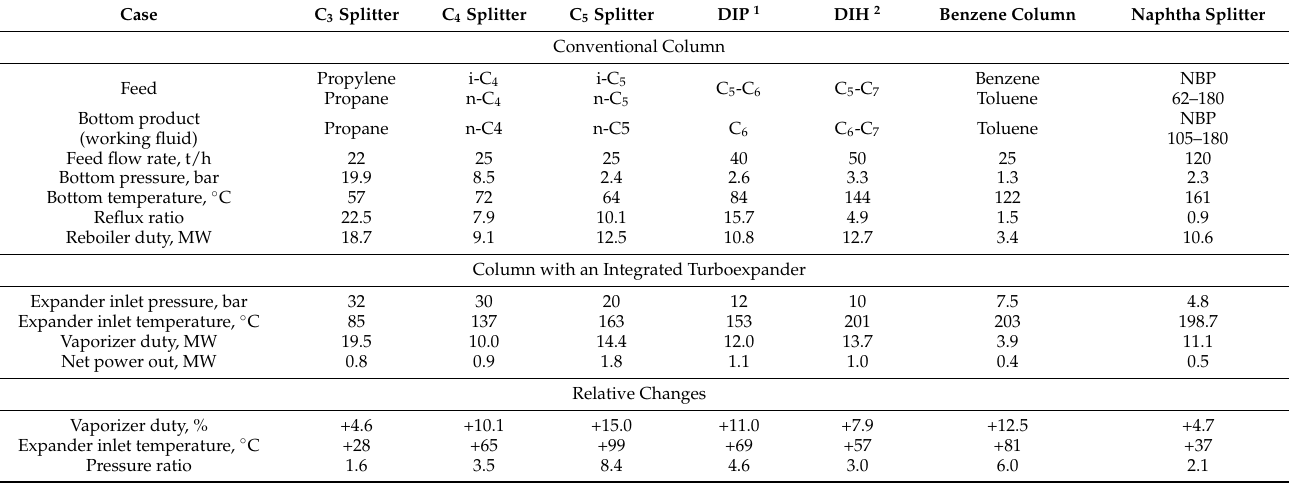
Table 3. Case studies of different column integration with a